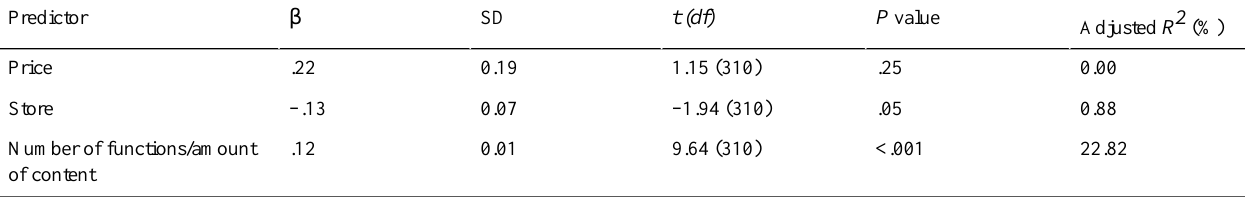
Table 3. Results of the regression analysis showing the predictors of app